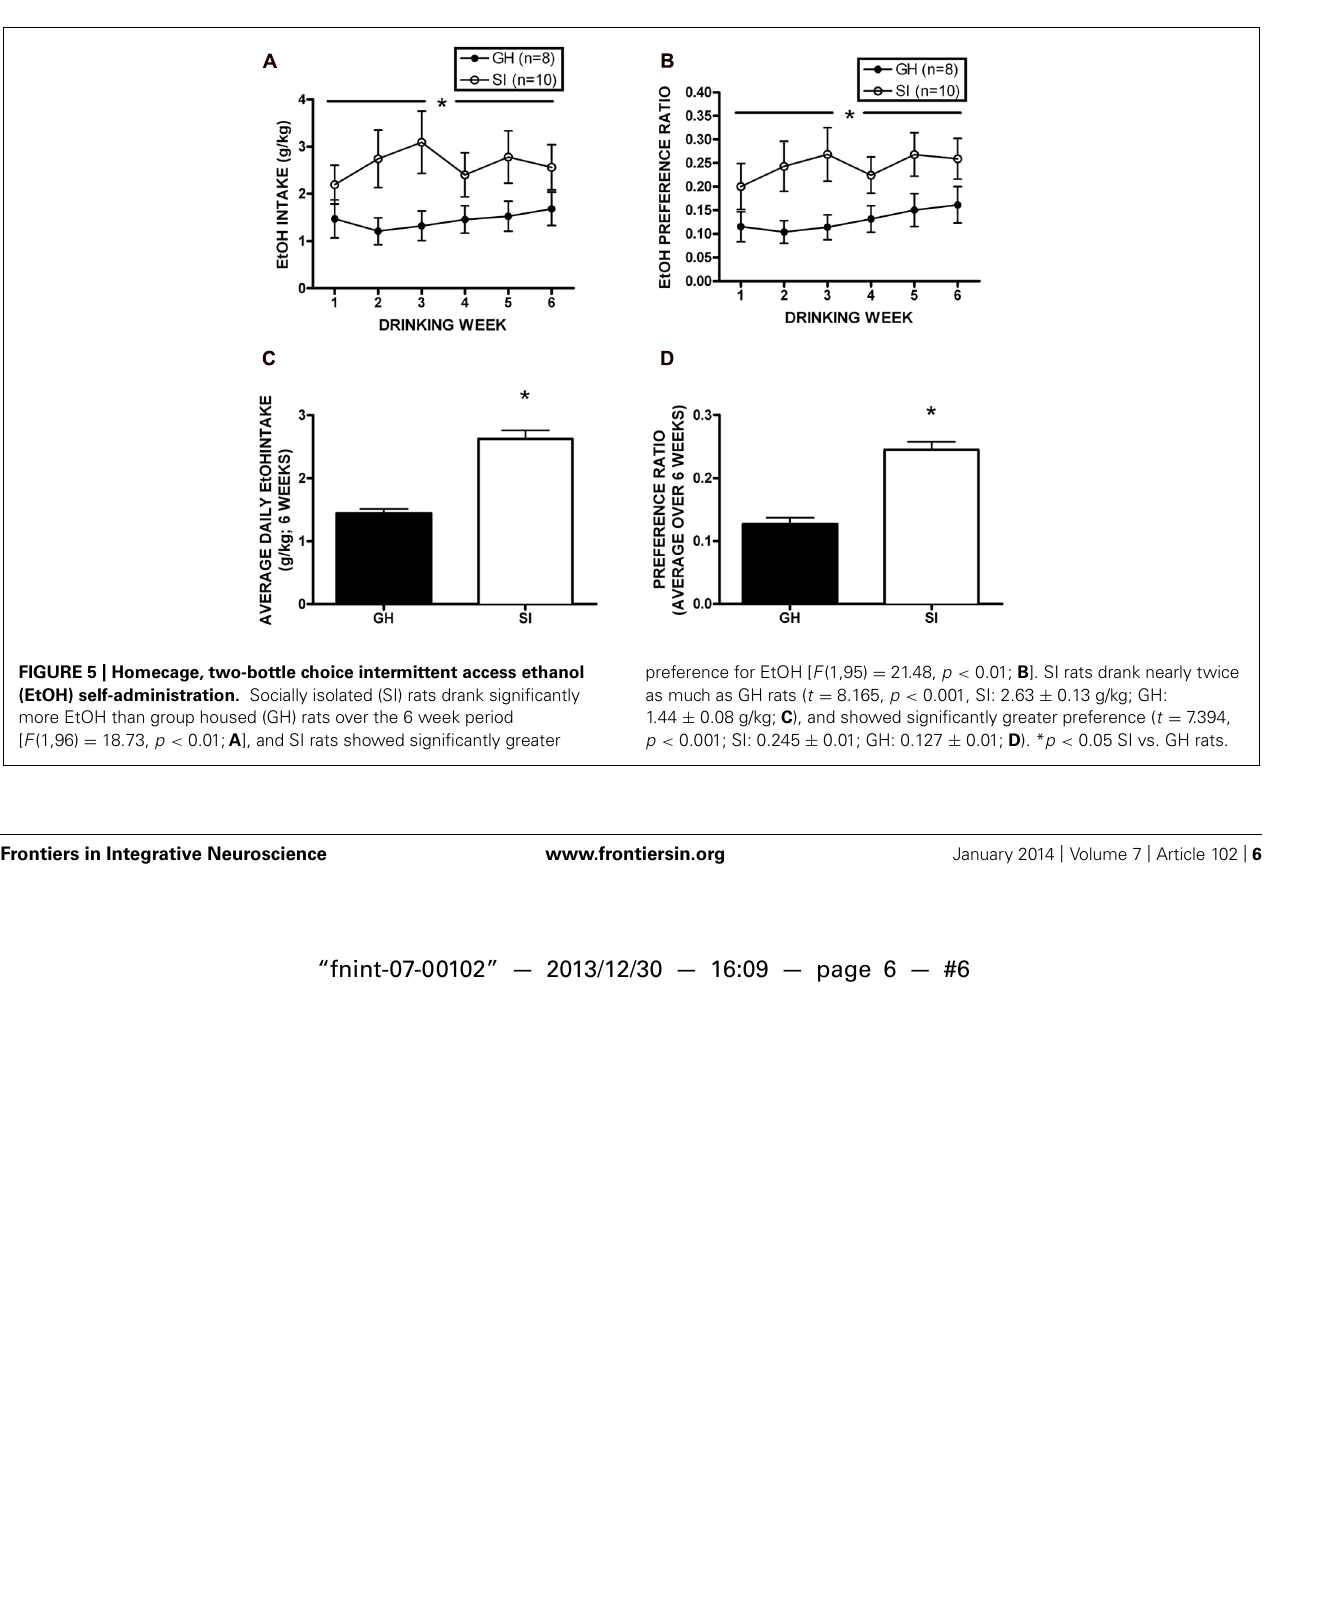
pre-treatment resulted in a significant suppression of CORT levels. (D) Follow-up t -tests within groups showed that SI rats failed to suppress CORT in response to DEX. * p < 0.05 baseline vs. post-stress.